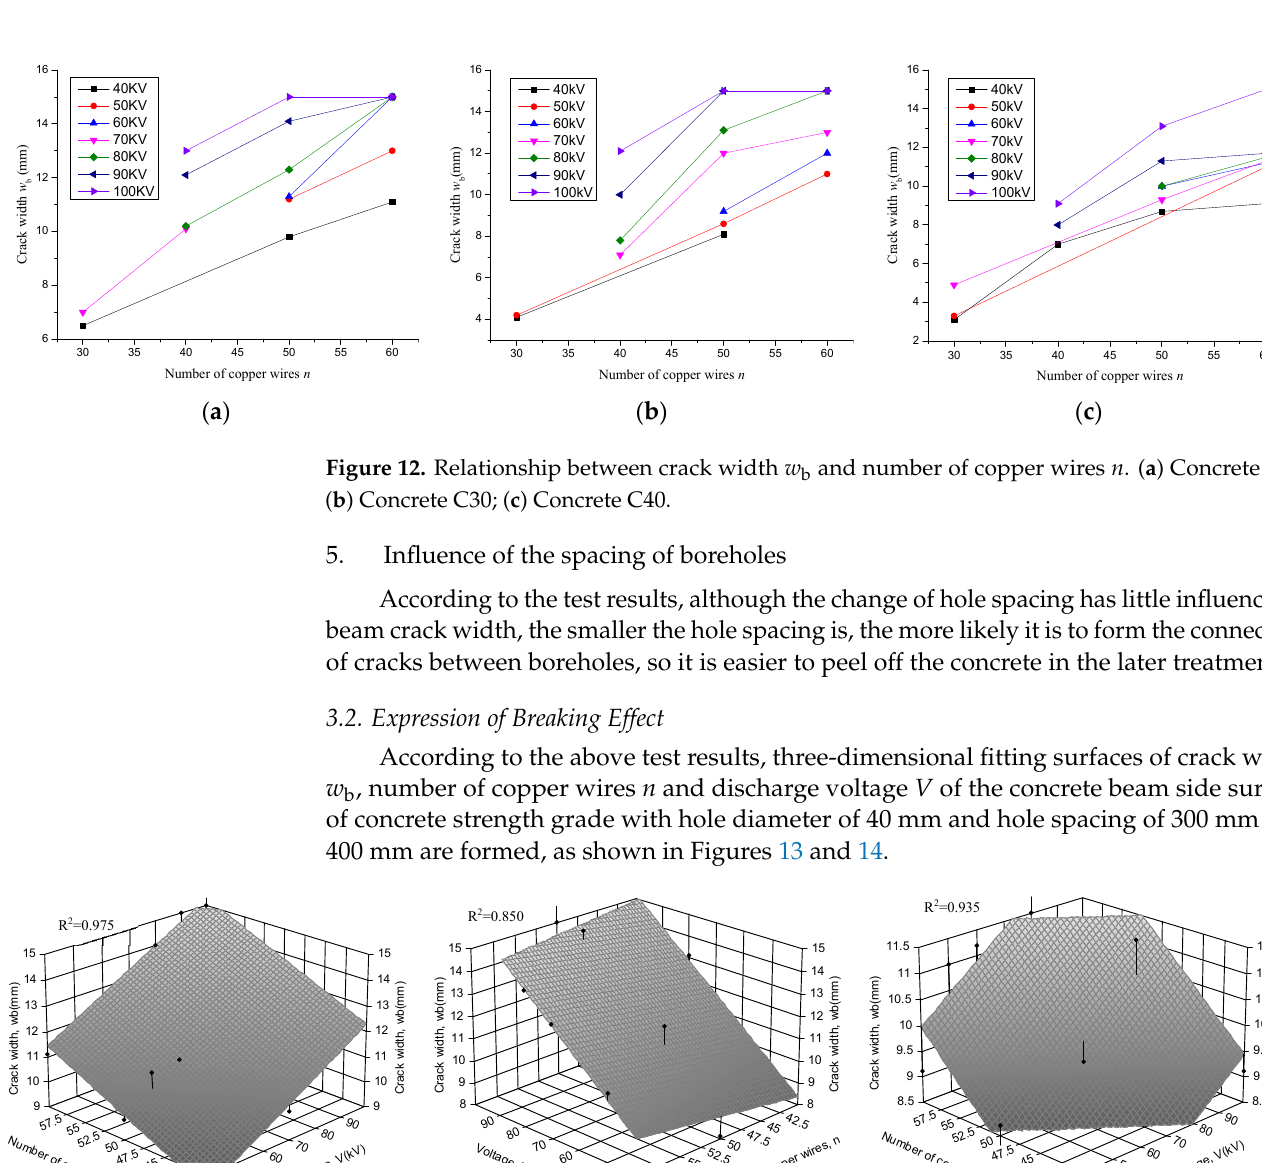
Figure 14. Fitting surface of concrete crack width with copper wire number and discharge voltage